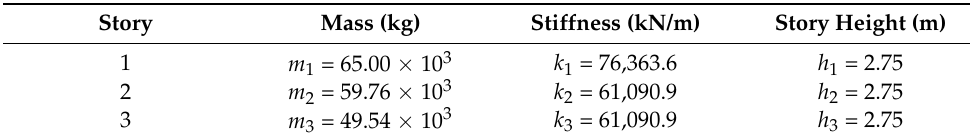
Figure 4. Three-story shear frame. The excitation comes from the ground, and the response of the third floor (roof) is collected. ( a ) Illustration of the three-story shear frame. ( b ) A typical attractor of the healthy structure in a three-dimensional reconstruction space. ( c ) A typical attractor of the healthy structure in the image space. Table 1. Parameters of the three-story shear frame.